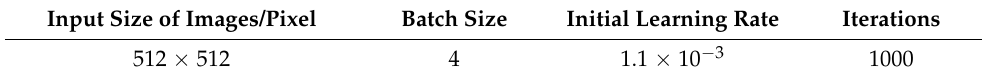
Table 1. The initialization parameters of BiSeNet V2